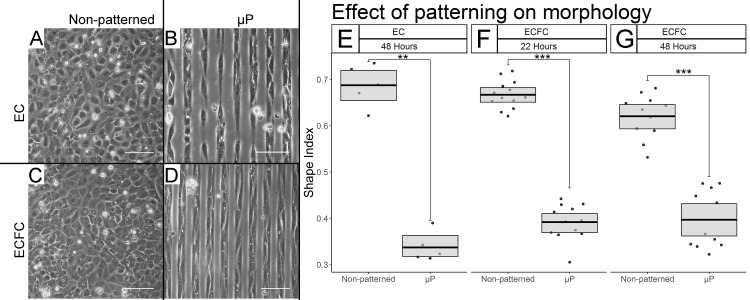
Spatial growth restriction micropatterning effectively growth restricts ECFCs and affects their gross morphology.Representative phase contrast light microscopy after 48 hours of culture at 20X (A-D) reveals effective growth restriction in ECs (B vs. A), and ECFCs (D vs. C) Scale bars = 100 μm. (E-G) Shape index quantification of EC and ECFC elongation. Box limits represent bootstrapped 95% confidence intervals, and crossbars represent means. Each point represents the mean SI of the 5–10 cells traced from each biological replicate. We find statistically significant micropatterning effects in ECs after 50 hours (E, p = 0.0052), and in ECFCs after 24 (F, p < 0.0001) and 50 hours (G, p < 0.0001).